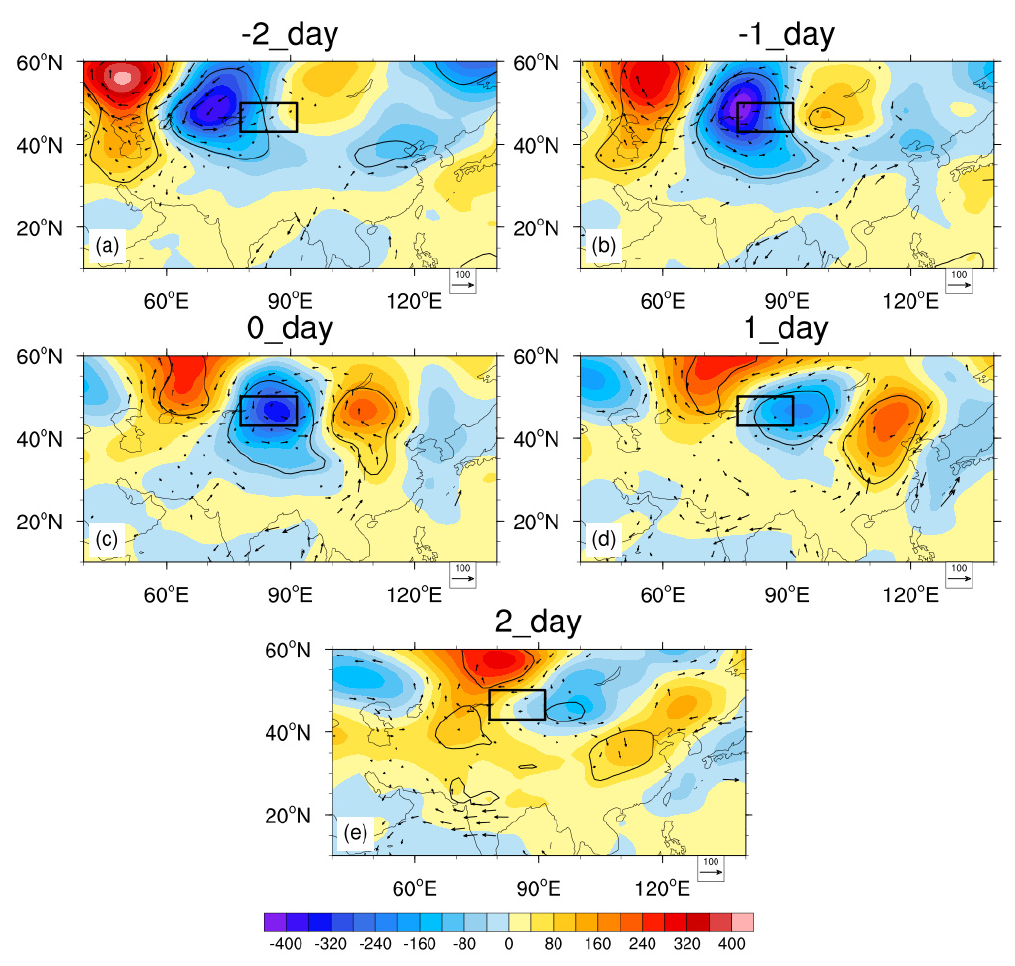
Figure 6. Composition of Z500 (contour) and Q anomaly (arrow) of Type EN on the extreme precipitation day and two days before and after ( a – e ) in the summers of 1979–2018 (Unit: gpm). The black box represents the location of the Northern Xinjiang region. The region over the 95% significant confidence level of geopotential height is circled with black lines, and only the part over the 95% significant confidence level of surface water vapor flux is shown.